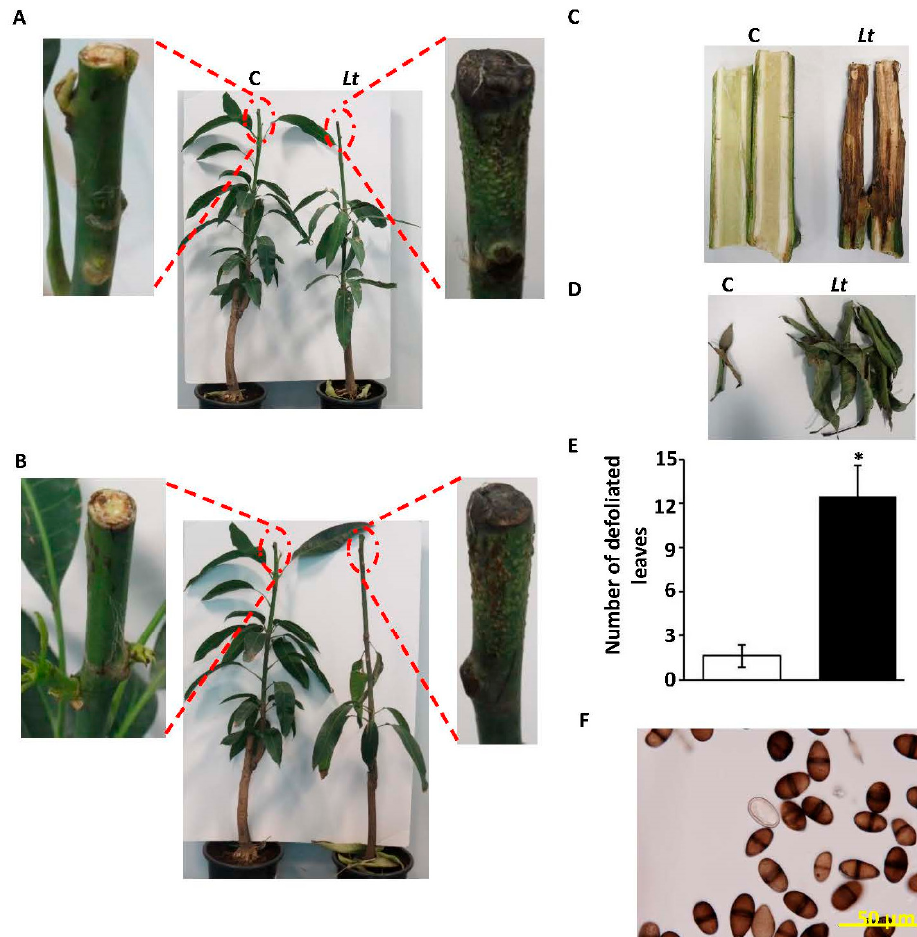
Figure 4. Pathogenicity and Koch’s postulate testing with L. theobromae . Pathogenicity test on inoculated (right) and non-inoculated (left) of seedlings at ( A ) 3 wpi; and ( B ) 5 wpi. Close-up views of symptomatic (right) and non-symptomatic (left) apical tip tissues at 3 and 5 wpi, respectively; ( C ) Longitudinal section of young stems showing browning of vascular tissues; ( D ) Defoliated leaves of inoculated (right) and control (left) seedlings; and ( E ) the number of defoliated leaves of inoculated (dark column) and control (clear column) seedlings, at 5 wpi. Asterisks are significantly different from the corresponding control at p < 0.05. ( F ) Conidia after re-isolation of the pathogen from colonized tissues.